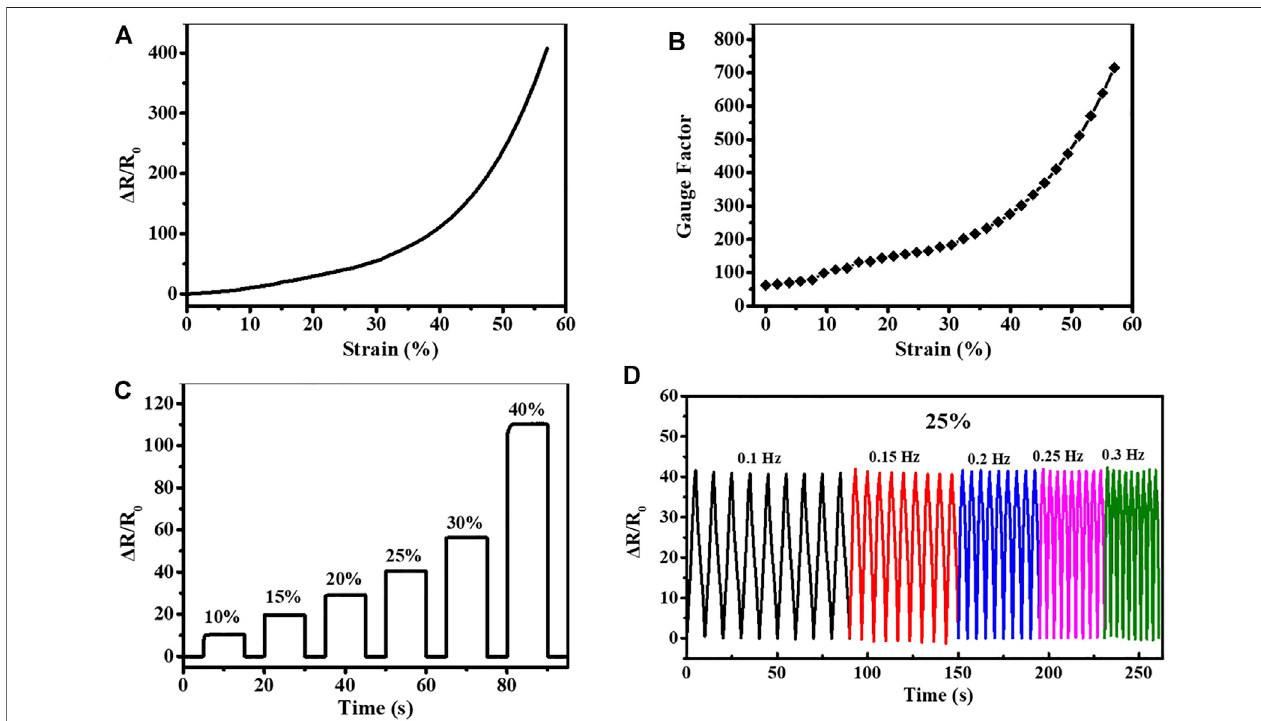
FIGURE 3 | Electrical properties of the graphene strain sensor. (A) Relative resistance vibration of the sensor during stretching; (B) the gauge factor of the sensor versus strain; (C) relative resistance vibration – time curve of the strain sensor under 10, 15, 20, 25, 30, and 40% strains with static-hold periods; (D) relative resistance vibration under cyclic stretching/releasing at frequencies of 0.1, 0.15, 0.2, 0.25, and 0.3 Hz.